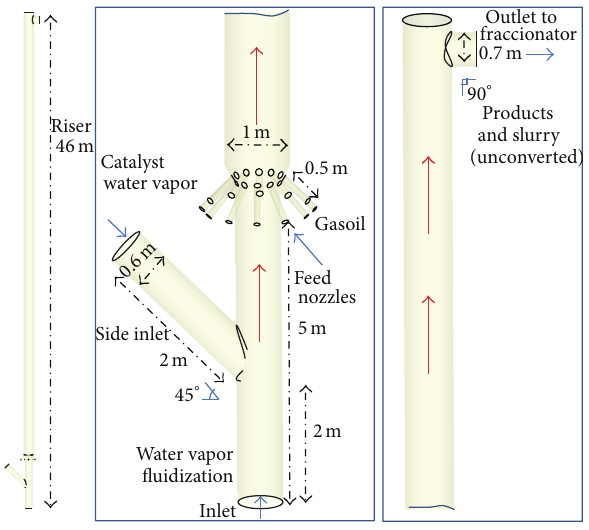
Figure 1: Riser geometry.